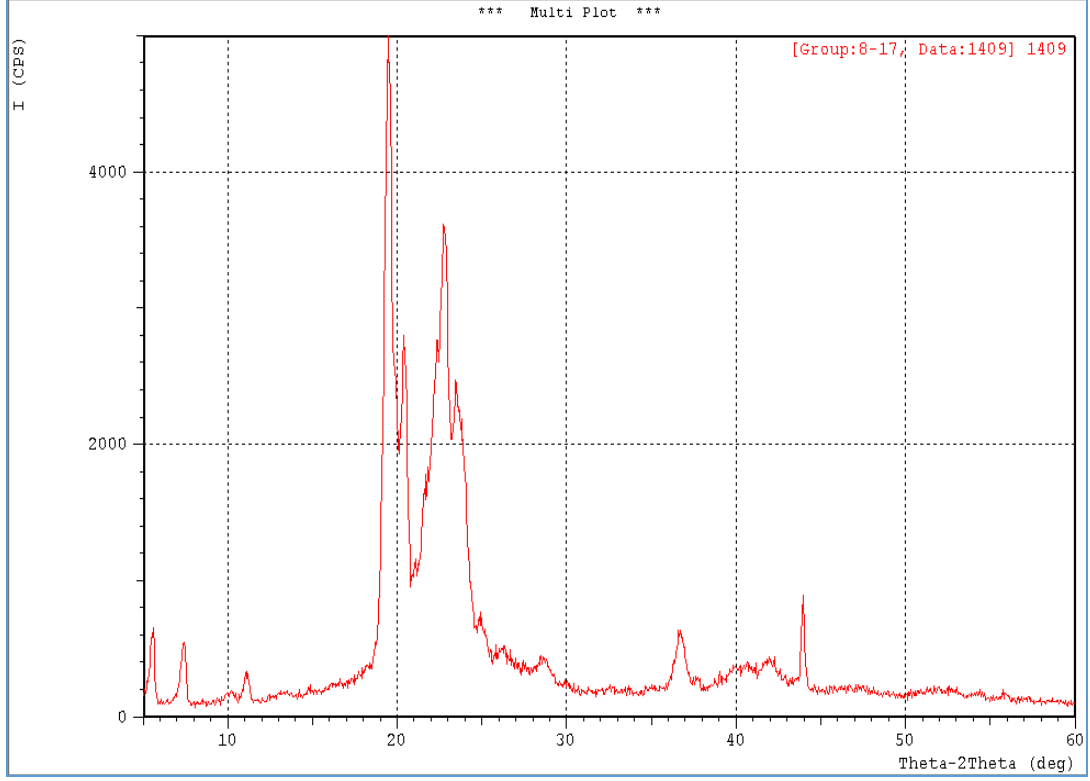
Figure 11 . X – Ray diffractograms of glyceryl monostearate (GMS ).